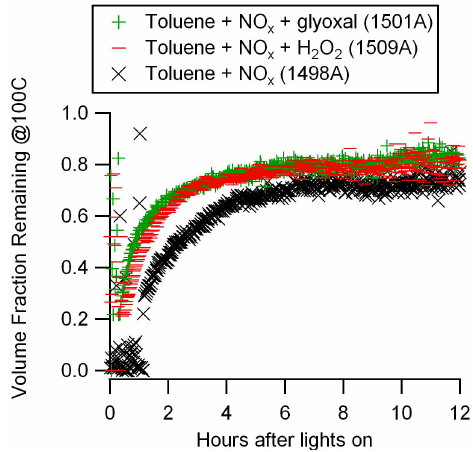
Fig. 5. The time traces of particle volume fraction remaining at 100 ◦ . Addition of both glyoxal and H 2 O 2 resulted in faster reac- tion and slightly less volatile particles, indicating that glyoxal acted as a radical source.